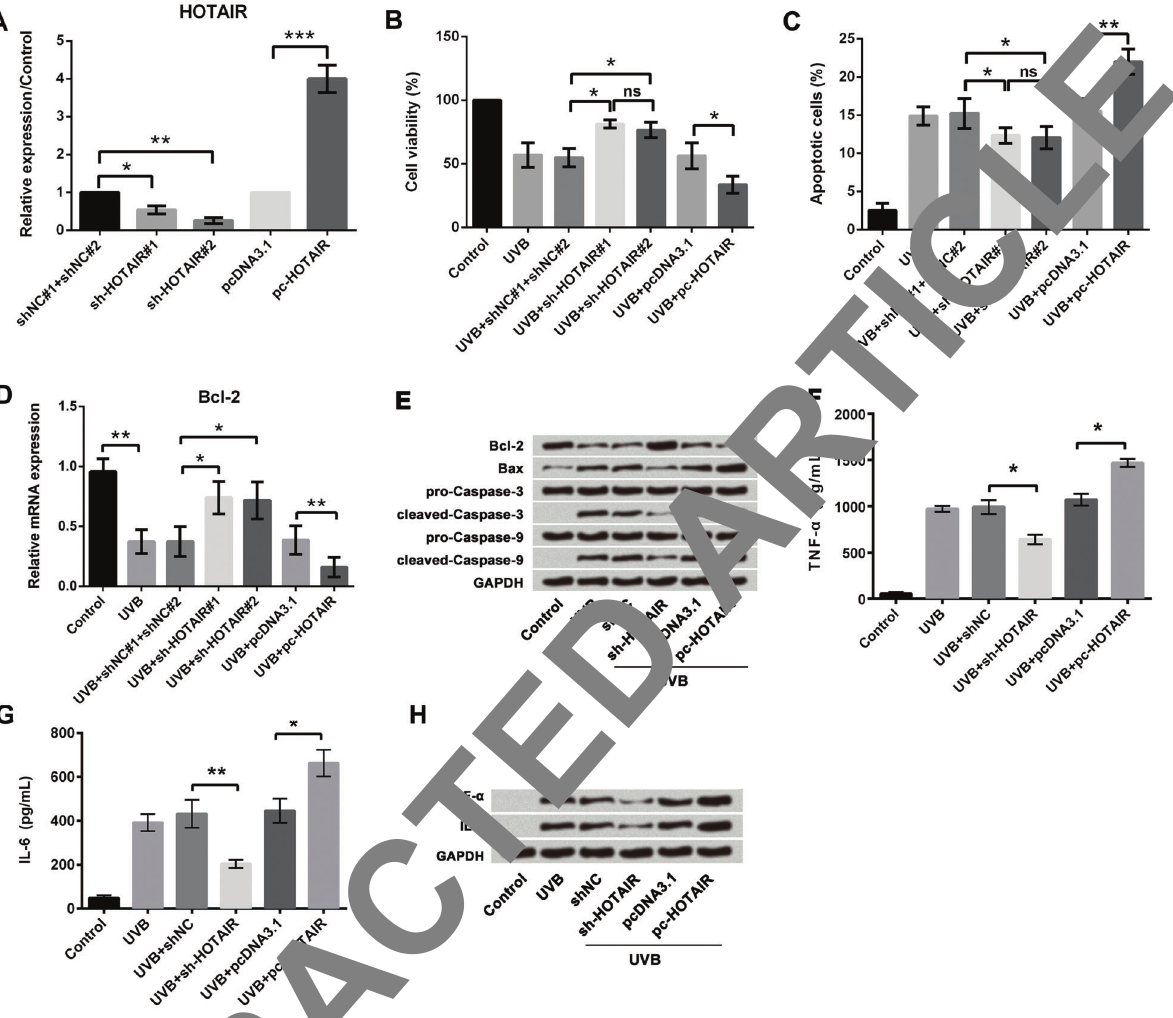
Figure 3. Effect of HOTAIR on UVB-induced cell injury; A , qRT-PCR revealed overexpression and suppression of HOTAIR in HaCaT cells after transfection assay; B , Cell viability assay revealed suppression of HOTAIR alleviated UVB-induced low cell viability and overexpression of HOTAIR further promoted UVB-induced inhibition of cell viability; C , Apoptosis assay revealed suppression of HOTAIR alleviated UVB-induced high cell apoptosis and overexpression of HOTAIR further promoted UVB-induced high cell apoptosis. D , qRT-PCR analysis showed that mRNA expression of Bcl-2 was increased after HOTAIR was silenced and decreased after HOTAIR was overexpressed. E , Western blotting analysis showed increased expression of Bax and decreased expression of Bcl-2 in HOTAIR overexpressed cells; F , ELISA results showed suppression of HOTAIR alleviated UVB-induced high expression of TNF- a and overexpression of HOTAIR further promoted UVB-induced high expression of TNF- a ; G , ELISA results showed suppression of HOTAIR alleviated UVB-induced high expression of IL-6 and overexpression of HOTAIR further promoted UVB-induced high expression of IL-6; H , Western blotting analysis showed increased expression of TNF- a and IL-6 with HOTAIR overexpression. Data are reported as means ± SD. *P o 0.05; **P o 0.01; ***P o 0.001 (ANOVA). ns: P 4 0.05. UVB treatment time was 16 h. HOTAIR: HOX antisense intergenic RNA; UVB: ultraviolet B; qRT-PCR: quantitative real-time polymerase chain reaction; TNF- a : tumor necrosis factor- a ; IL-6: in UVB-treated cells. The results indicated that suppres- and #2 transfection group. Due to the higher transfection sion of HOTAIR alleviated UVB-induced cell injury and ef fi ciency of sh-HOTAIR#2, it was used for subsequent overexpression of HOTAIR further promoted UVB-induced studies. We also found that inhibiting HOTAIR expression cell injury. decreased the expressions of Bax, cleaved caspase-3, The effects of HOTAIR on HaCaT cells with no UVB and cleaved caspase-9 (Figure 3E). Inhibiting HOTAIR treatment were also analyzed in this study (Supplemen- expression reduced TNF- a (P o 0.05; Figure 3F and 3H) tary Figure S1). Inhibiting HOTAIR increased cell viability, and IL-6 (P o 0.01; Figure 3G and H) compared with sh-NC